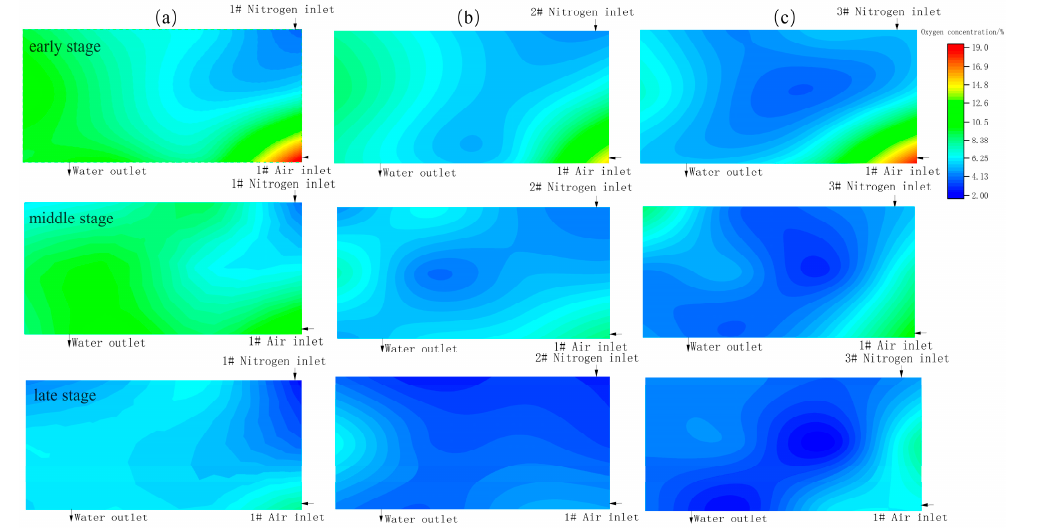
Figure 7. Change characteristics of SC hazardous area in the goaf under different nitrogen injection positions. ( a ) 1# nitrogen injection, ( b ) 2# nitrogen injection, ( c ) 3# nitrogen injection.